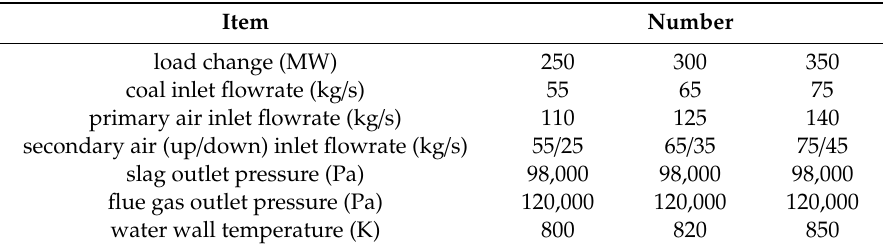
Table 5. Input parameters for the simulations.